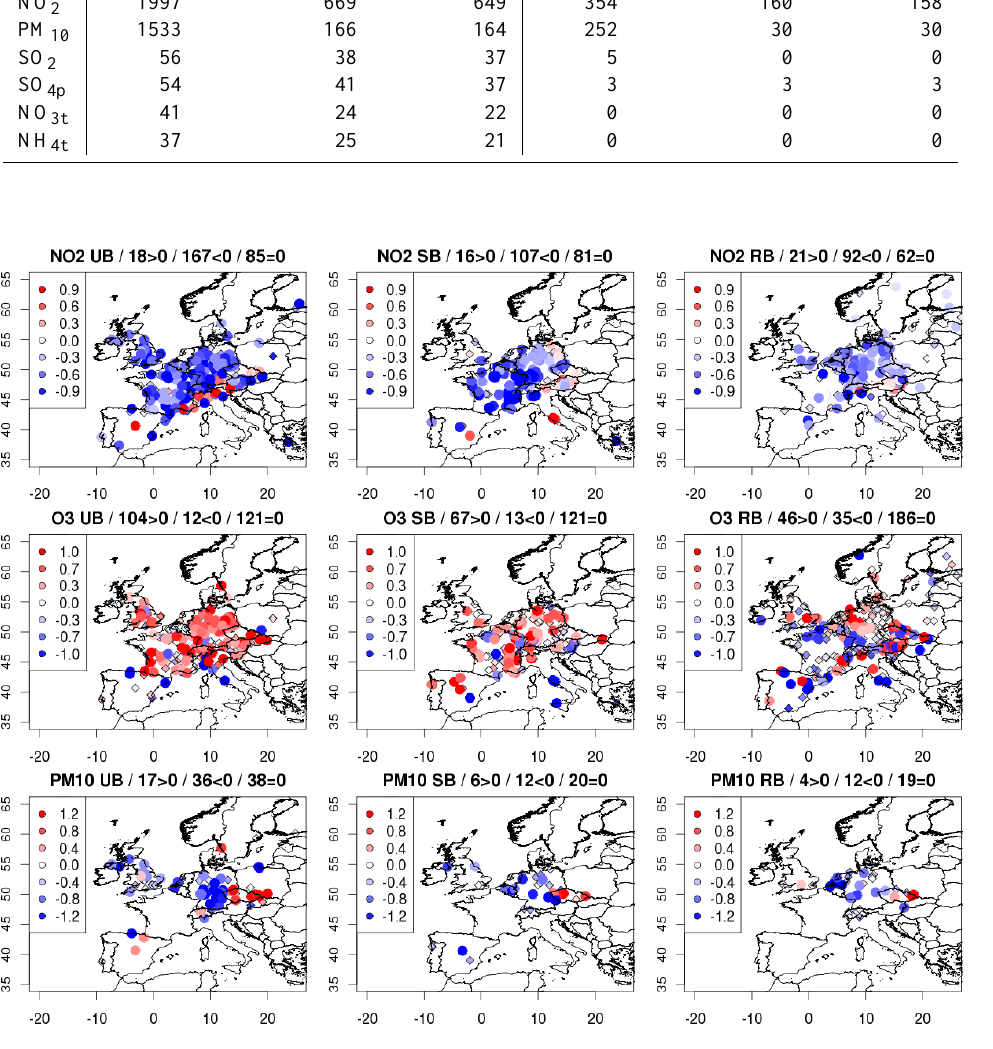
Figure 1 : Trends of daily means of NO 2 , O 3 , and PM10 (µg/m3/yr) observed at urban background (UB), suburban background (SB) and rural background (RB) AIRBASE stations. Stations where a statistically significant trend is observed are shown with a large dot a small diamond is used otherwise. The title of each panel also provides the number of stations with a positive, negative or null (not significant) slope.